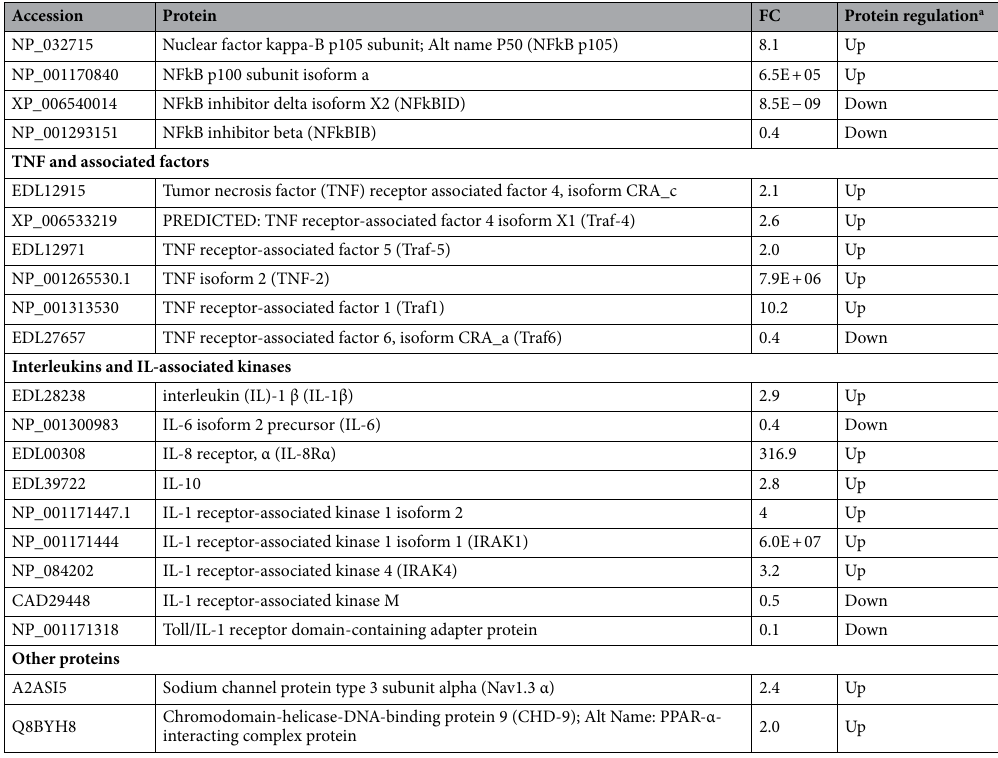
Table 2. Global protein changes detected by mass-based spectrometry analysis. Fold change determined from total protein spectral intensity of RAGE isoforms and downstream signaling pathways from cultured tDRG neurons maintained in either control conditions or incubated in LPS for 24 h. To classify proteins as up- or down-regulated, we considered the fold change (FC) of ≥ 2 and < 0.5 in spectral intensities with respect to control. a Up-regulated proteins—FC ≥ 2; Down-regulated proteins—FC <